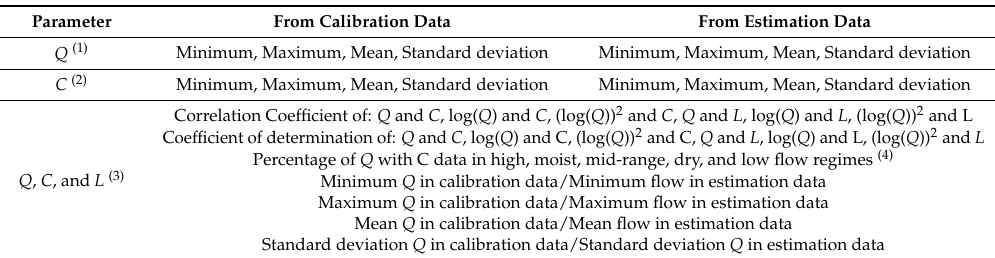
Table 2. Statistics in calibration and estimation